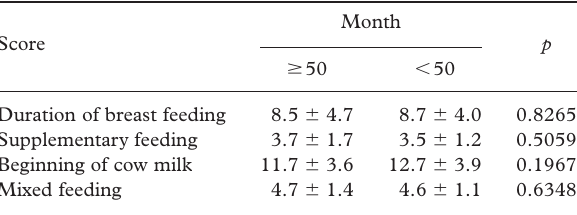
Table II. Feeding practices and dietary habits in infancy. Score